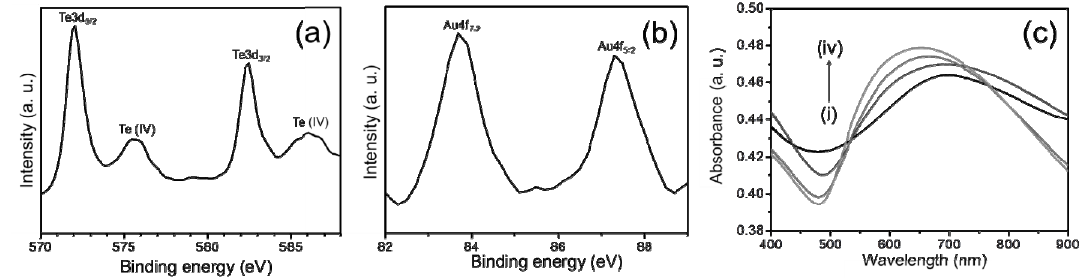
Figure 3. ( a,b ) XPS spectra of the Te-Au NWs on carbon fiber fabrics; ( c ) UV/Vis absorption spectra of the Te NW-based carbon fiber fabrics reacting with 0 (i), 0.5 mM (ii), 1 mM (iii), and 2 mM (iv) HAuCl 4 .